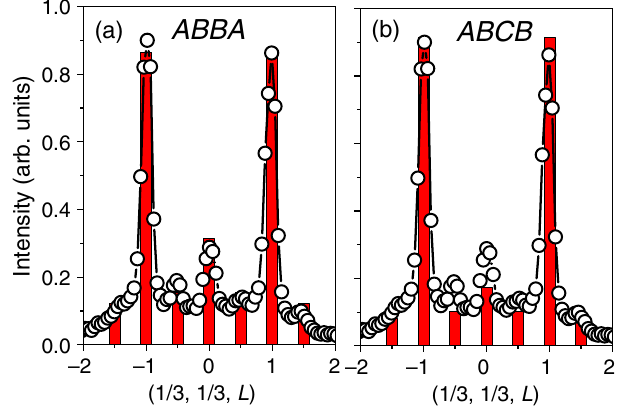
FIG. 13. Description of neutron-diffraction data using a mixture of bilayer phase AB and four-layer phases with (a) ABBA and (b) ABCB spin-stacking sequence. The calculated intensities at Bragg peak positions are indicated by red columns.